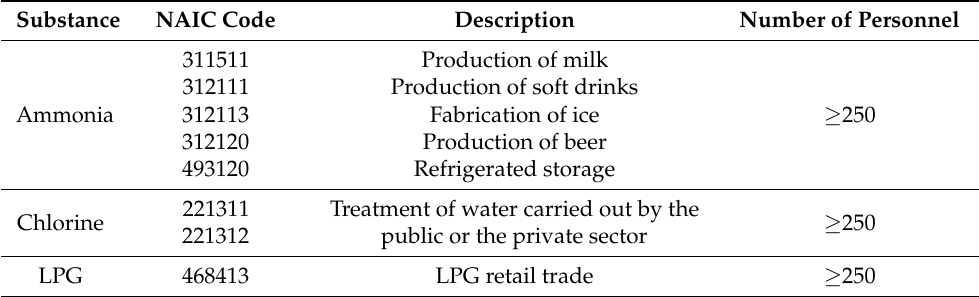
Table 1. NAICS classification of facilities